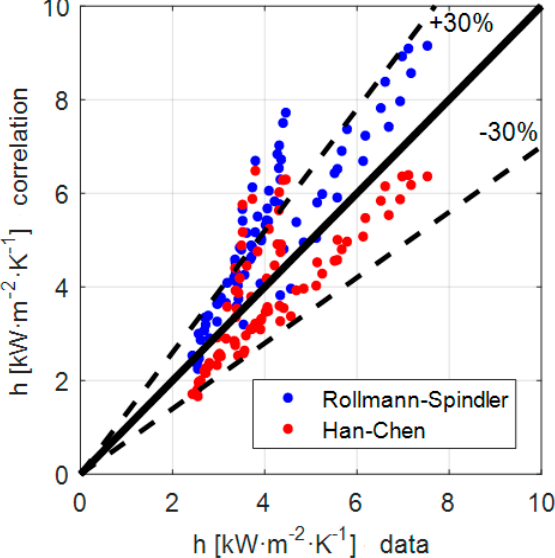
Figure 9. Comparison between the experimental data and the best performing correlations developed for the heat transfer coefficient. Table 5. Comparison between the experimental data concerning the pressure drop per unit length and the predictions provided by some of the correlations available in the open literature.